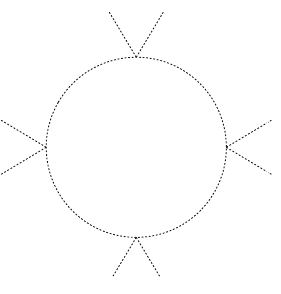
Figure 1 . Radiative generation of R 2 n